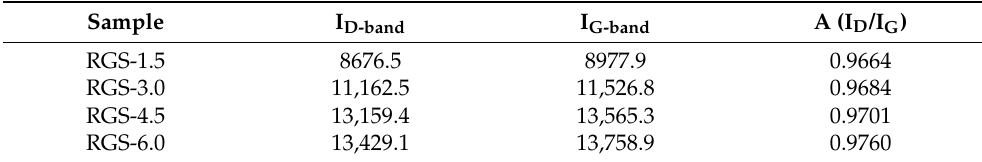
Figure 3. Raman spectra: ( a ) RH-SBA-15, and ( b ) RH-GO/SBA-15 for different amounts of GO suspension. Table 1. The intensity ratios (I D /I G ) of Raman spectra for different amounts of GO suspension of adsorbent samples.